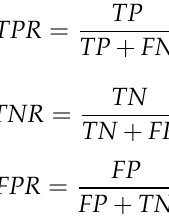
Figure 2. The most frequent features counted over all reporting times for the blackhole and flooding for both NS15P7 and NS1P3 scenarios: ( a ) Most frequent features in the blackhole case; ( b ) most frequent features in the flooding case.